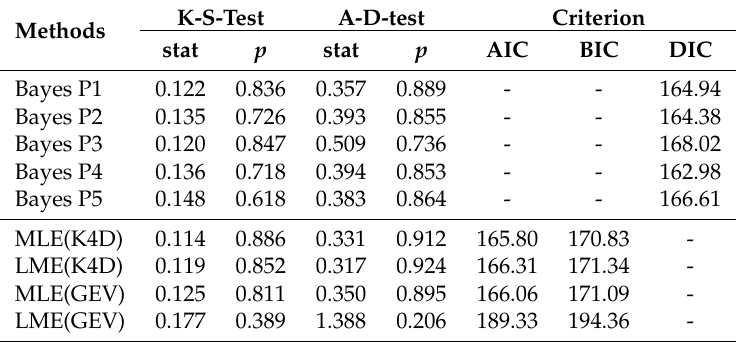
Table 2. Comparison of the K-S-test, A-D-test, AIC, BIC, and DIC obtained by MLE, L-moments, and Bayesian estimation methods with the five priors (P1–P5) considered in the Section 4.2 for the annual maximum wind speed data (unit: km/h) at Udon Thani, Thailand, 1990–2015. K-S: Kolmogorov-Smirnov, A-D: Anderson-Darling, AIC: Akaike information criterion, BIC: Bayesian information criterion, DIC: deviance information criterion, P: p